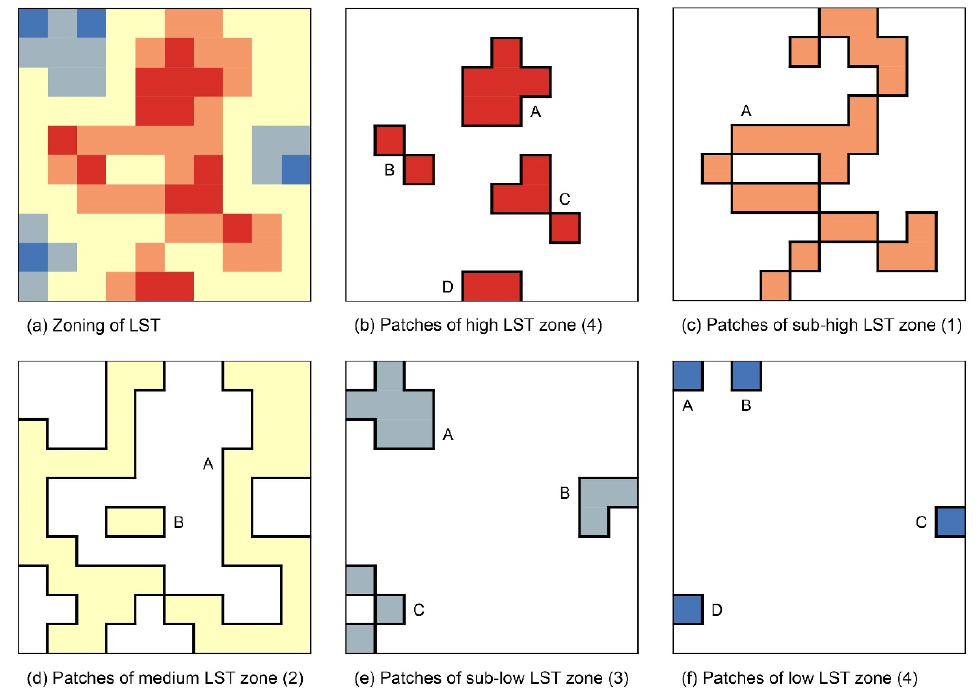
Figure A1. The definition of thermal landscape patches. A patch refers to a part of space that is different in appearance or property from the surrounding environment but has some internal homogeneity and is identified via patch boundaries distinguished by discontinuities in the environmental character states from their surroundings of magnitudes.